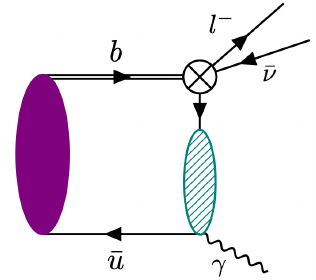
Figure 1 . Factorization of the B − → γ ‘ − ¯ ν decay amplitude in the region where E γ . m B / 2 . The crossed dot represents the hard function H , while the hatched green ellipse denotes the radiative jet function J with an external photon. The B -meson LCDA is represented by the violet ellipse. The double line denotes a soft heavy-quark field in